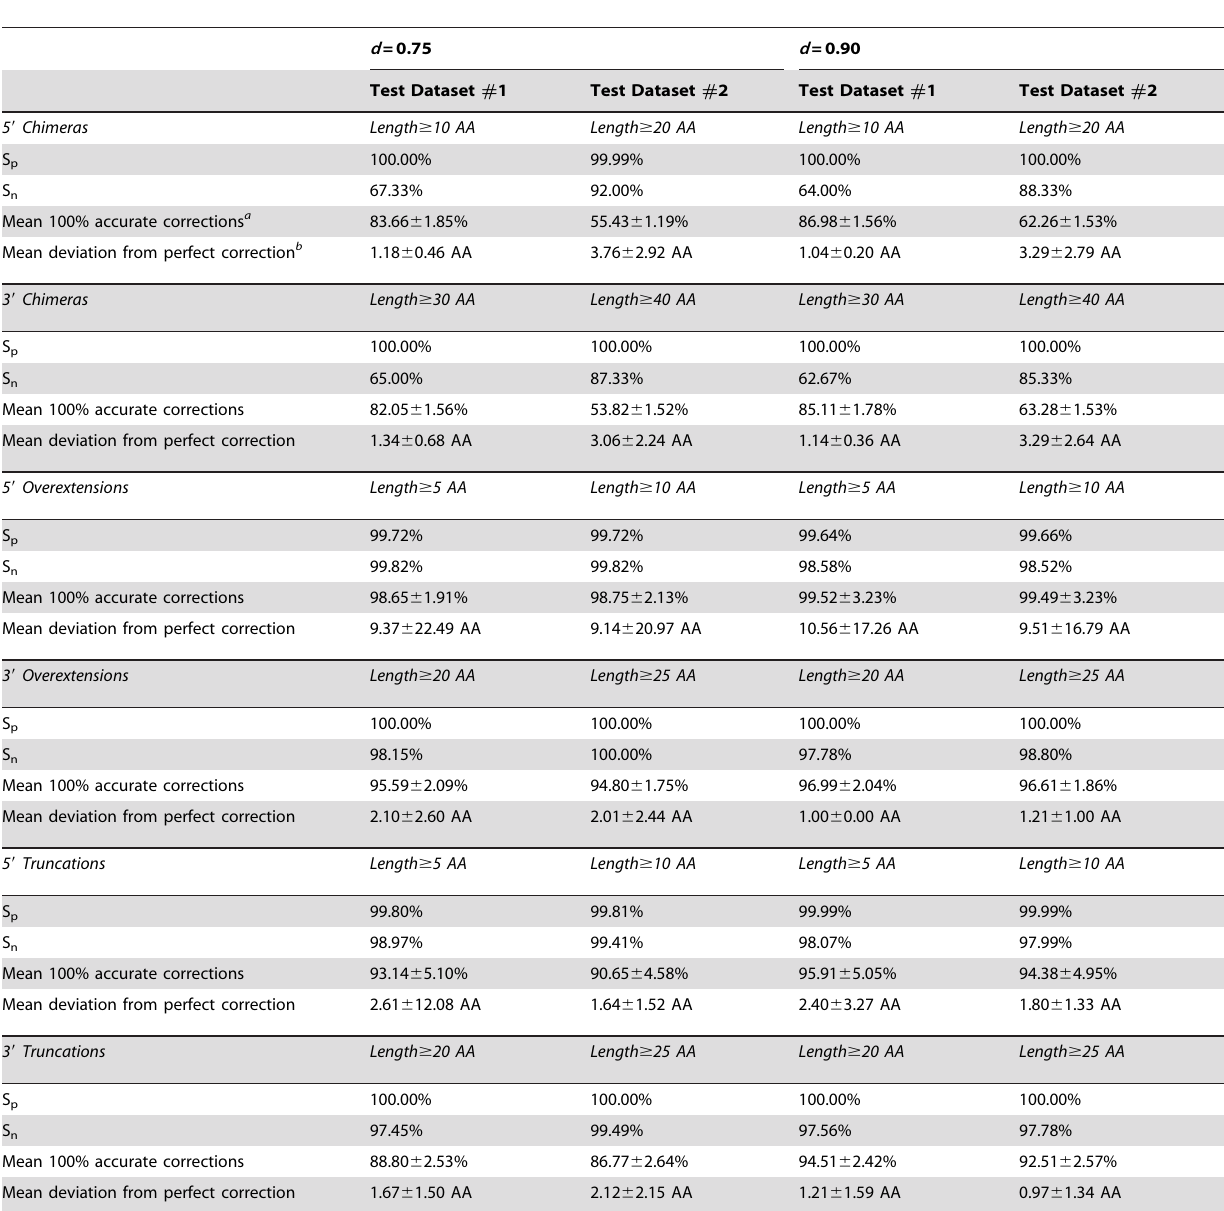
Table 1. Performance of ORFcor run on simulated inconsistency-containing data in comparison to known values using the parameters: a = 5; b =10; d =0.75 or 0.90; f = 10; g = 30; l = k =